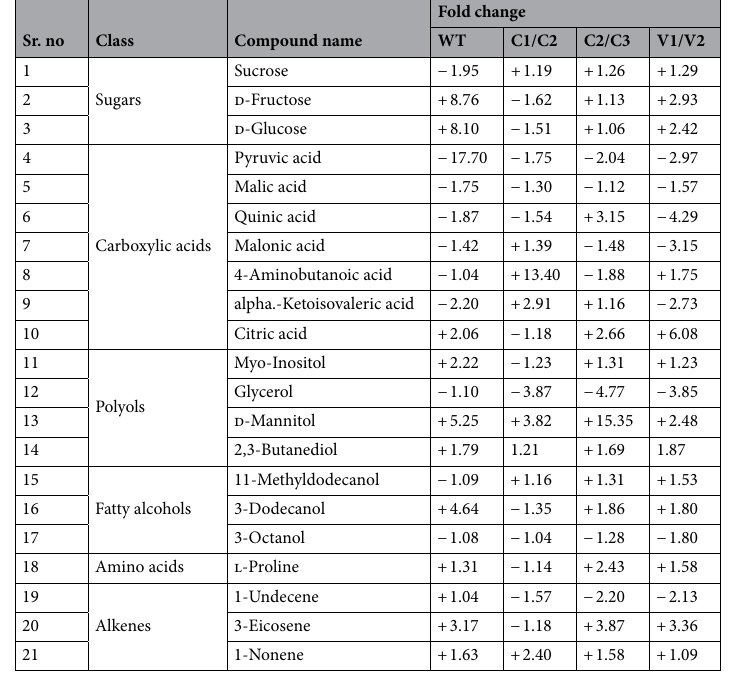
Table 4. The fold change in the metabolites in WT and amiRNA transgenics after JLCuGV agroinfiltration. The increase and decrease in fold change is indicated by + and − sign,